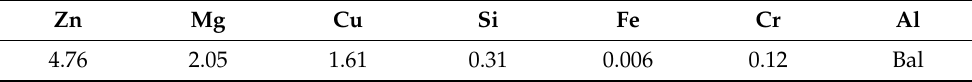
Table 1. Chemical composition of the 7075 Al alloy (wt%). Zn Mg Cu Si Fe Cr Al 4.76 2.05 1.61 0.31 0.006 0.12